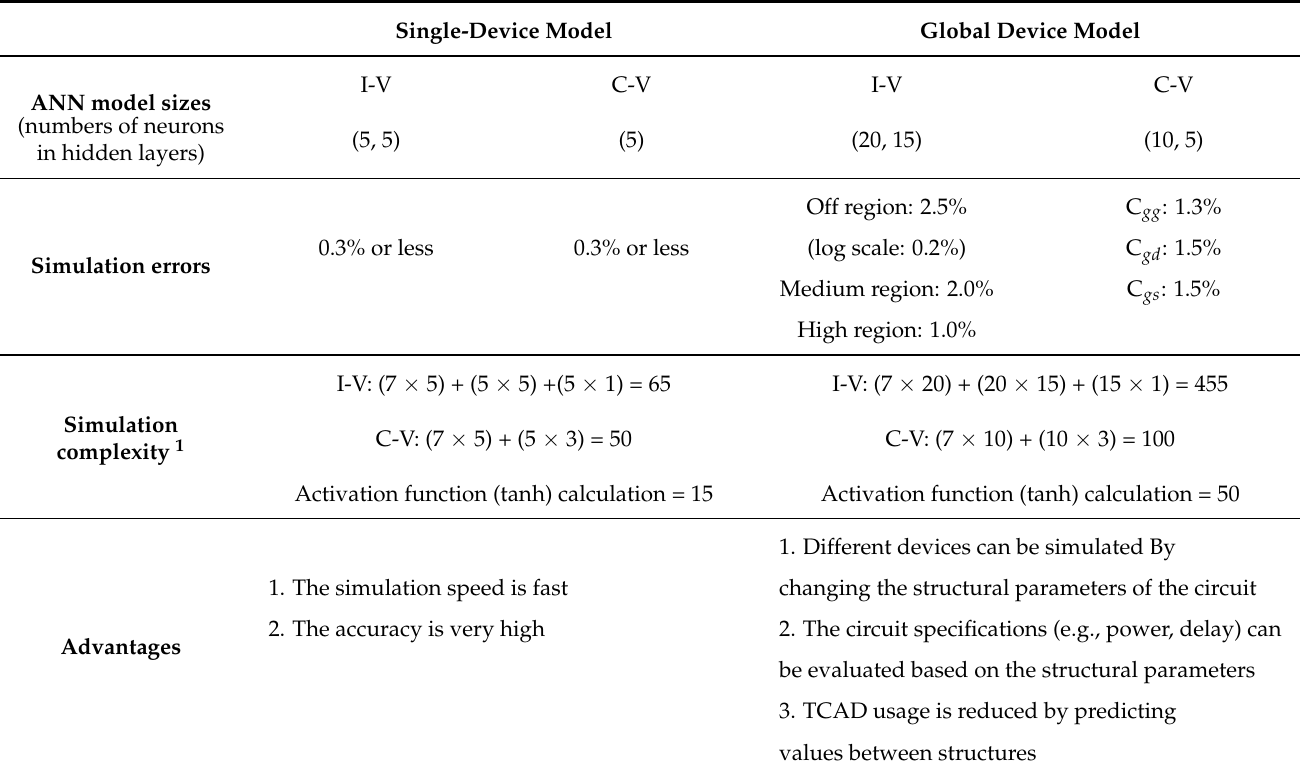
Table 4. Characteristics of the single-device model and the global device model.